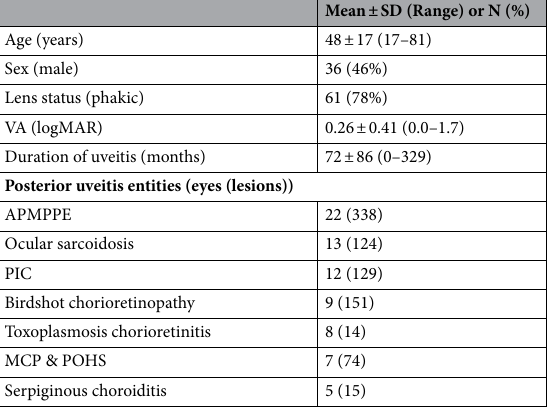
Table 1. Characteristics of the sample. SD Standard deviation, VA (best-corrected) Visual acuity, PIC Punctate inner choroidopathy, APMPPE Acute posterior multifocal placoid pigment epitheliopathy, MCP Multifocal choroiditis and panuveitis, POHS Presumed ocular histoplasmosis